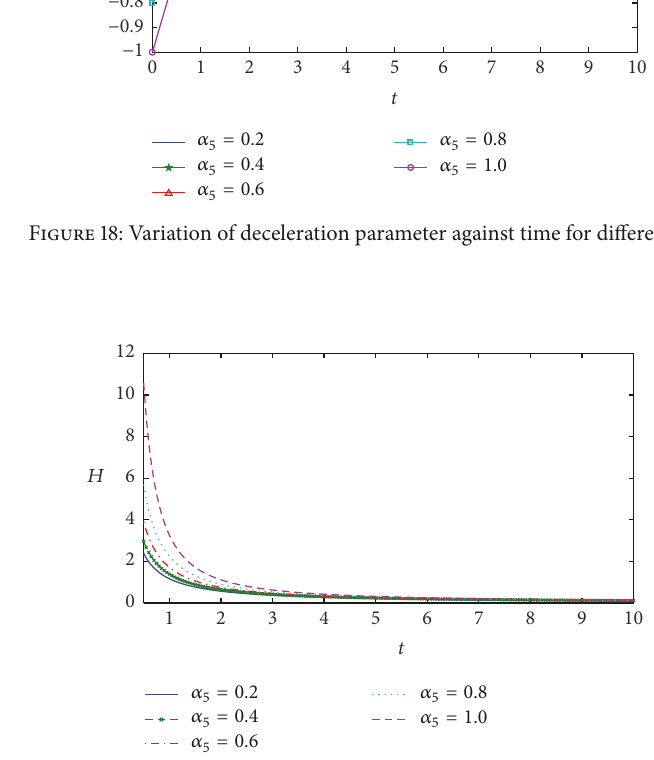
Figure 19: Variation of Hubble parameter against time different 𝛼 5